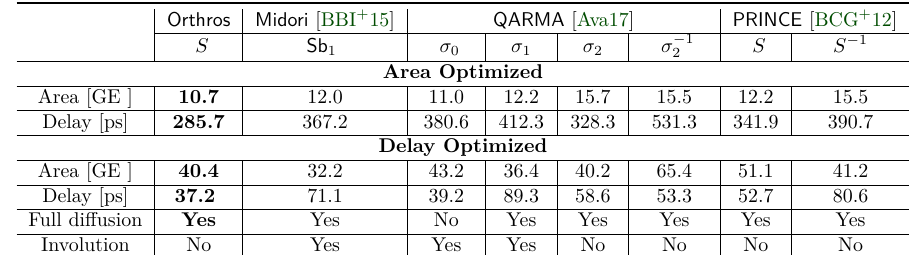
Table 7: Comparison of